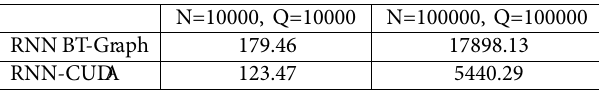
Table 3. Comparisonon the executiontime of RNN BT-Graph and RNN-CUDA.